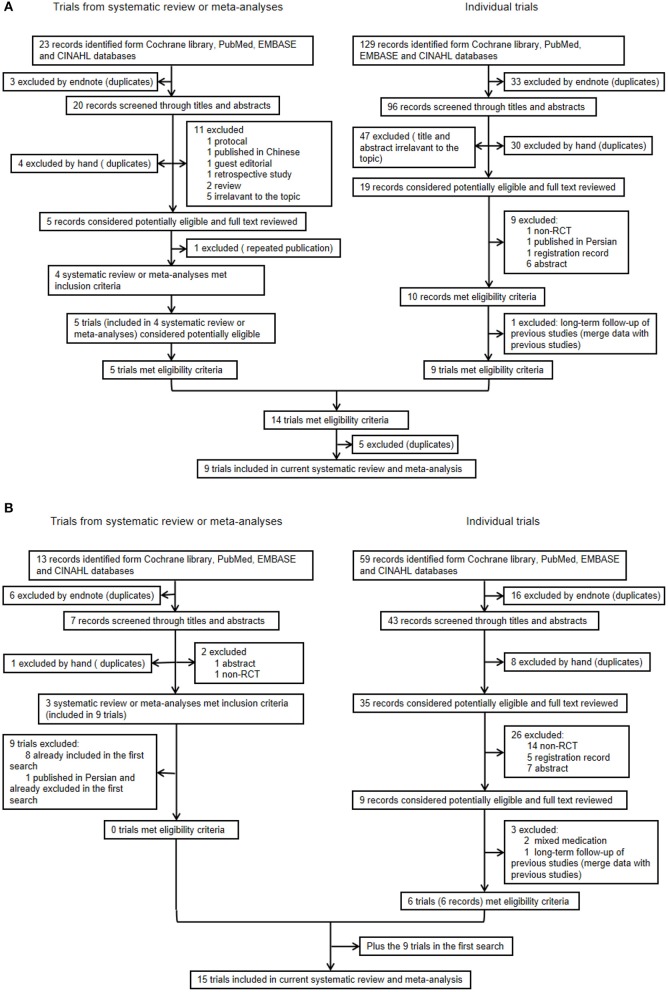
(A) Flow chart (first search) and (B) Flow chart (second search).